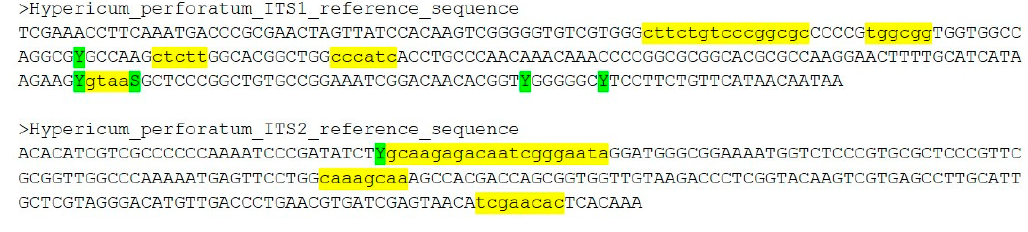
Figure 6. Proposed H. perforatum reference sequence from the ITS1 and ITS2 regions. Lower case bases (yellow highlight)—exact match required; Uppercase bases—exact match not required (95% identity required overall). Polymorphic positions in H. perforatum are shown with ambiguous single code letters (green highlight).